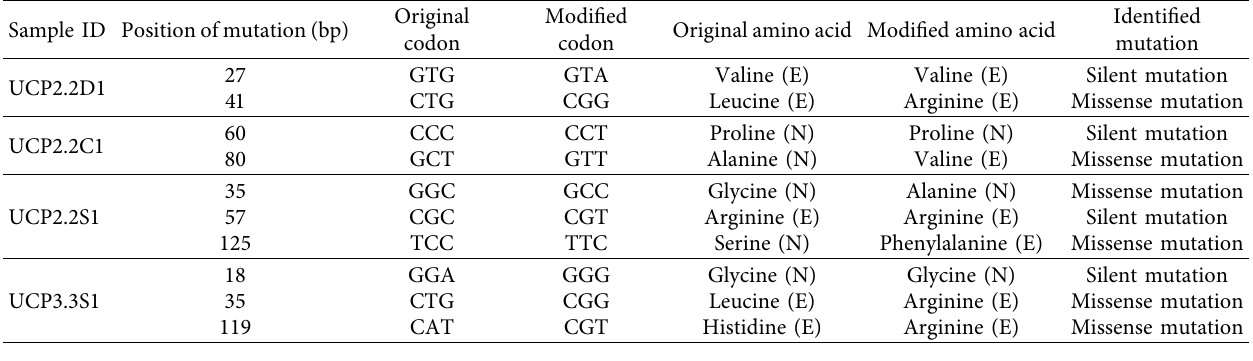
Table 3: Genetic code-based identified mutations and deduced amino acids.